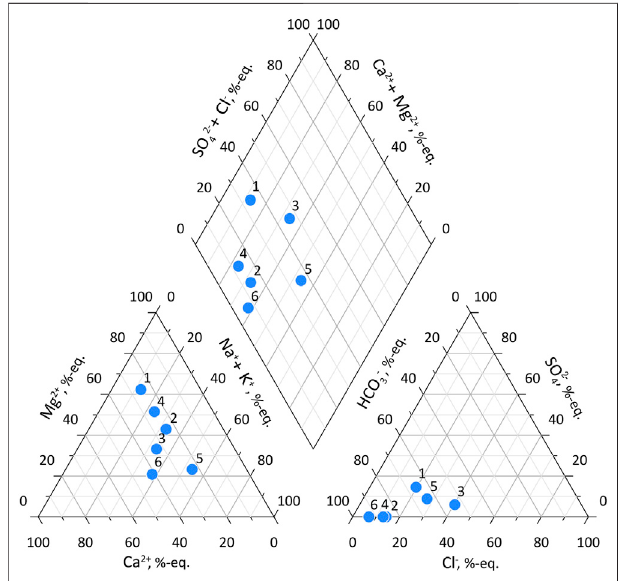
FIGURE 6 | Piper diagram ofthe chemical composition of ice wedges of the Mamontova Gora outcrop according to the authors (this article) and Kuznetsov (1976), %-equiv. 1) ice wedge of the upper tier (our results), 2) ice wedge of the upper tier (Kuznetsov, 1976), 3) ice wedge of the lower tier (our results), 4) ice wedge ofthe lower tier (Kuznetsov, 1976),5) modern ice of the fl oodplain (our results), 6) Holocene ice of a 6 – 9 m terrace (Kuznetsov,